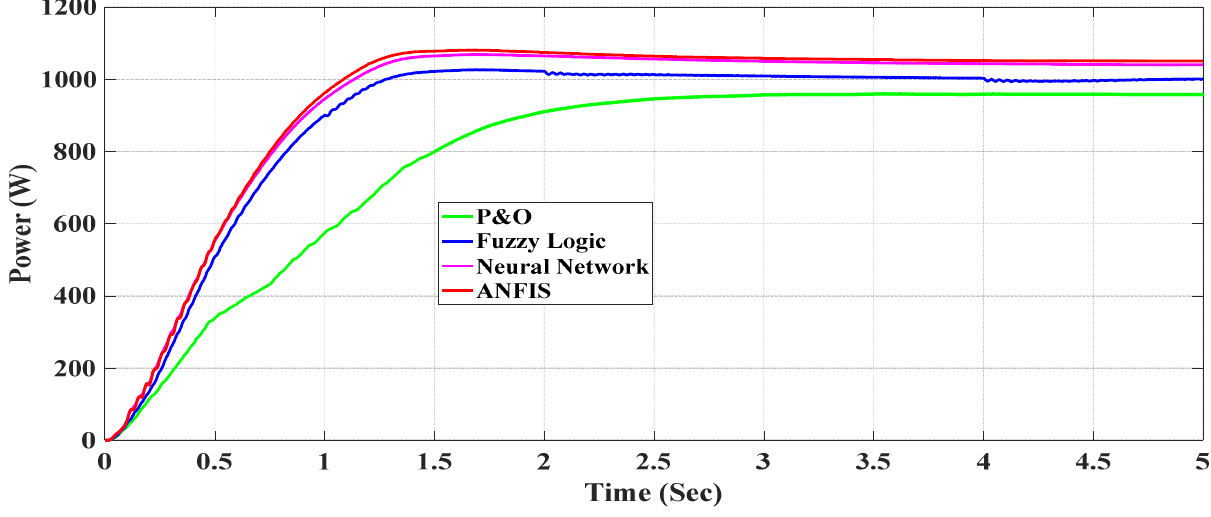
Figure 38. Response of Hybrid RES Power with P-&-O, F-LC, AN-N and AN-FIS MPPT Controllers to the Variation in SR, WS and